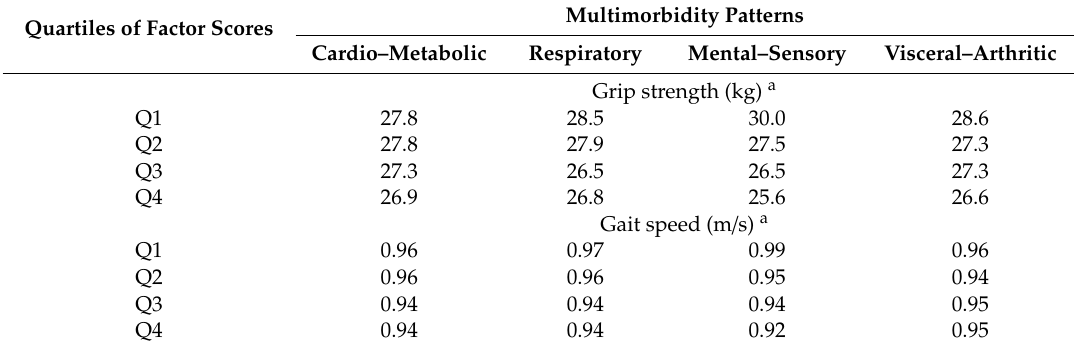
Table 4. Predicted physical performance for multimorbidity patterns among older Chinese adult participants of the most recent survey (N = 10,112).